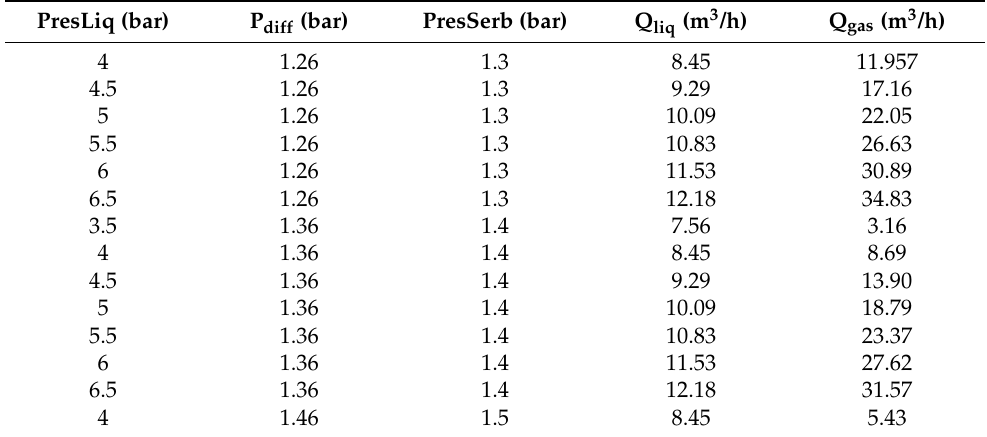
Table 2. Extract of operating data for current ejector configuration (D1 = 11 mm and D2 = 29